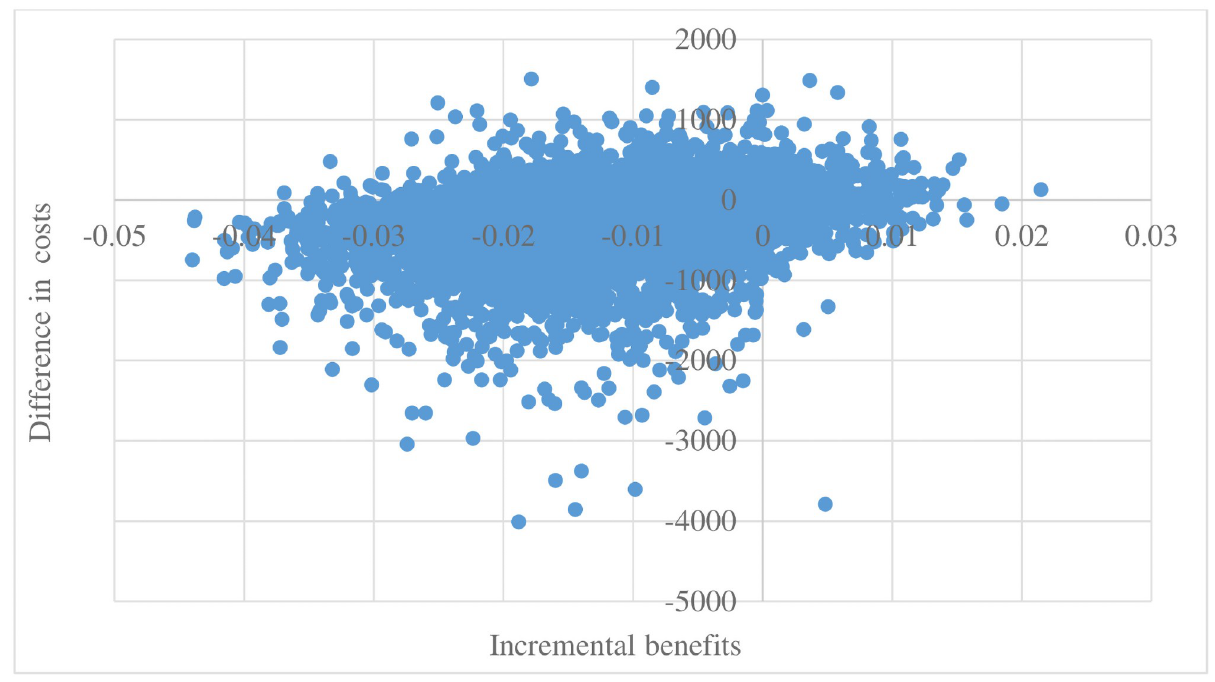
Fig 3. Cost-effectiveness scatter plot (COVID-19 period).